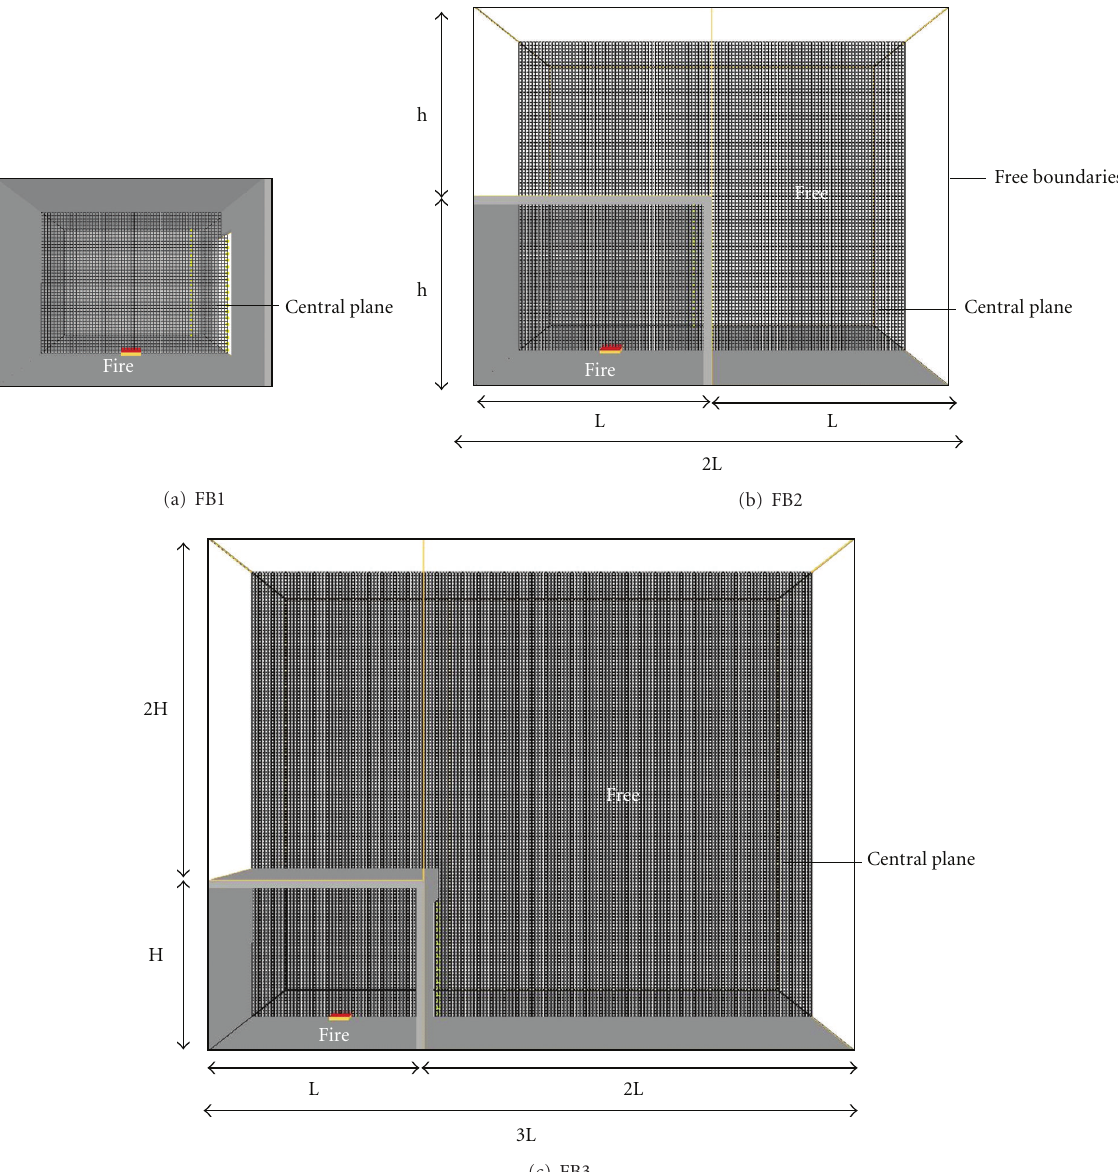
Figure 8: Three free boundary